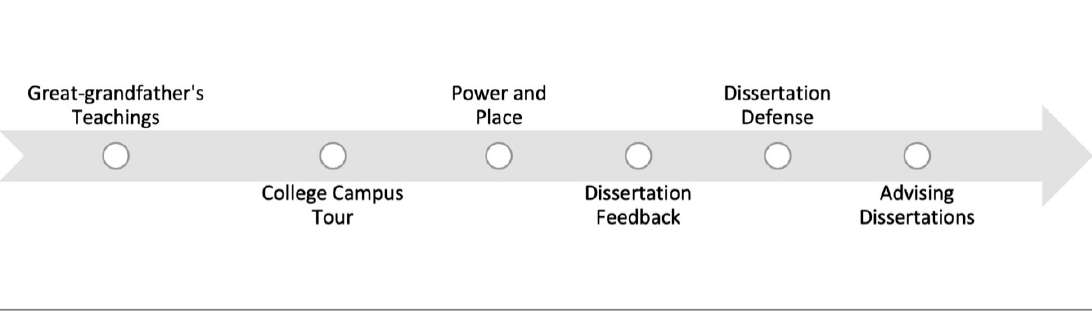
Figure 3. Cyclical continuum of stories. Furthermore, the dashed lines intersect at one meeting point. I position the lines to show I am intentionally connecting these stories. The arcs of the lines may change over time, and the points of intersections will change. Changing intersections means I will con- tinually learn from the same stories and reinterpret the stories as new stories enter my life. At this moment, these sets of stories have worked together to help me identify how au- thenticity and vulnerability helped me define what is unapologetically Indigenous in the academy means. For each set, I first share each pair of stories. Then, I frame a discussion